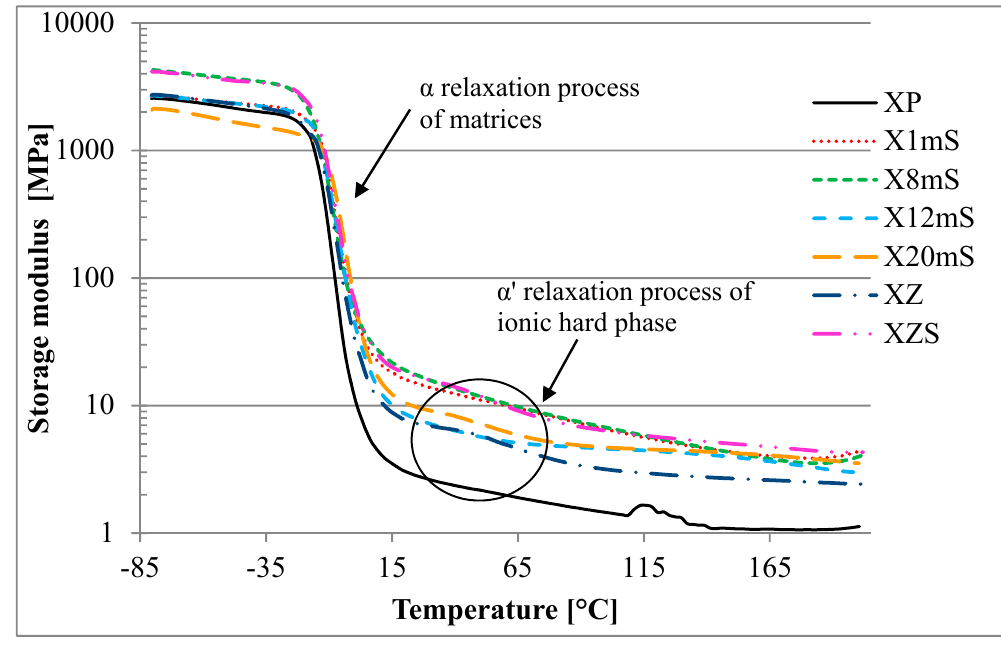
Figure 3. The temperature ( T ) dependency of storage modulus ( E’ ) at 5 Hz for XNBR vulcanizates.